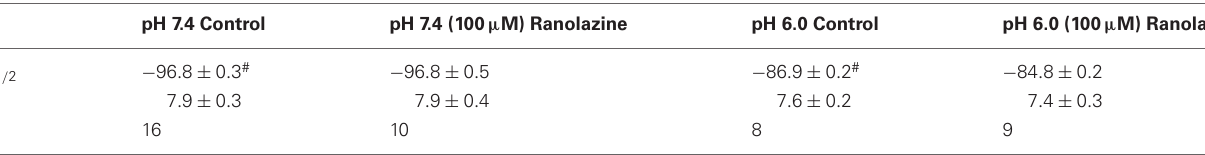
Table A3 | Steady state fast inactivation.